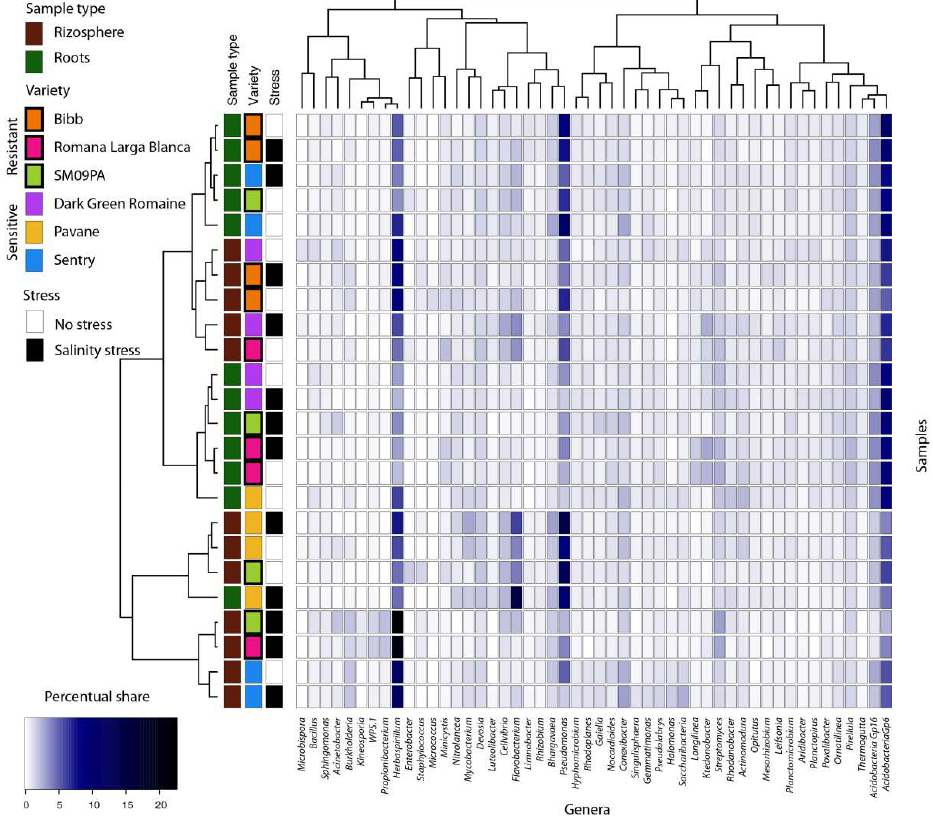
Figure 3. Heatmap of bacterial genera composition in roots and rhizosphere of six lettuce varieties in normal conditions and under salinity stress. Only genera with min. 2% occurrences in any samples are listed. Dendrograms are based on occurrence of genera in samples (Bray–Curtis distance, complete clustering).